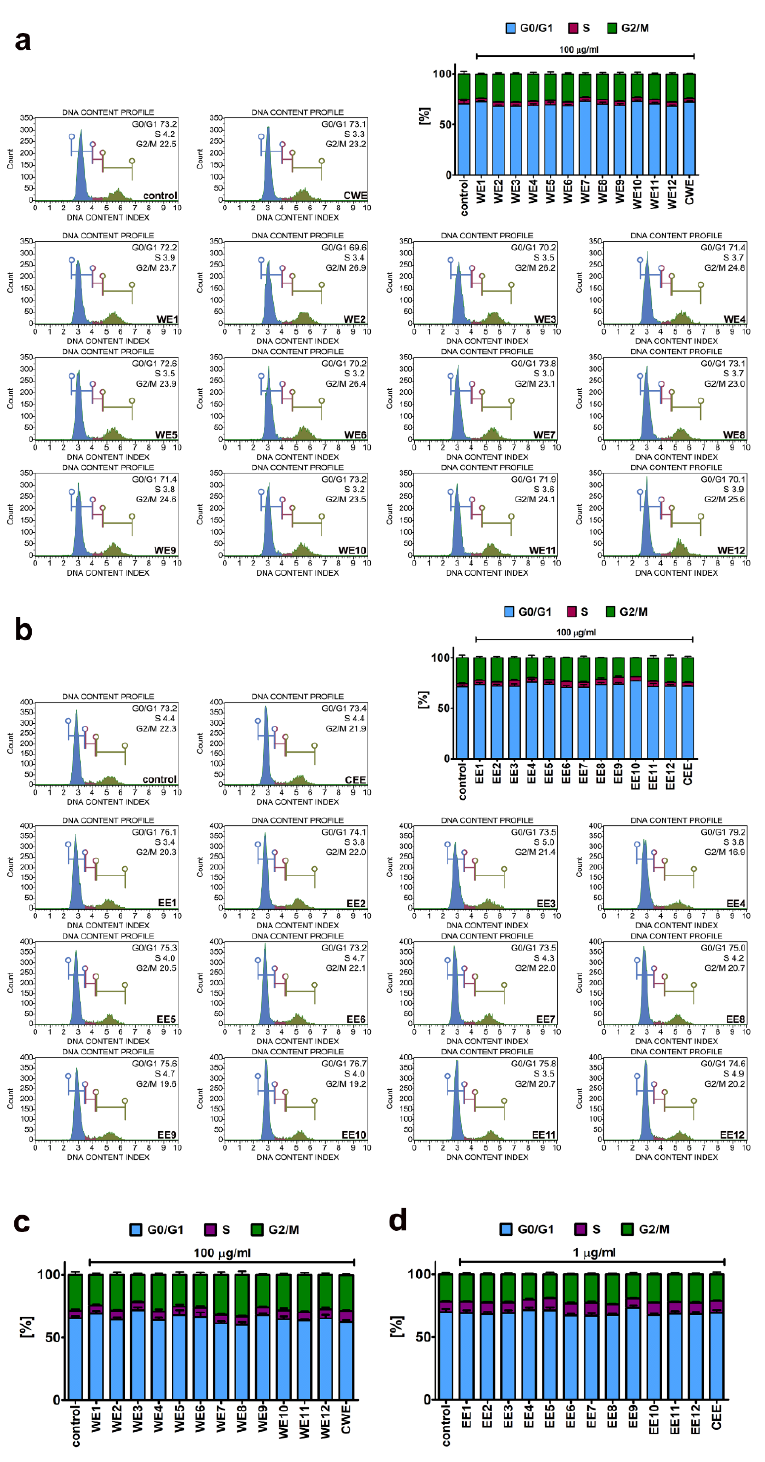
Figure 3. Extract-mediated changes in the cell cycle of BJ cells (( a ), 100 µ g / mL water extracts; ( b ), 100 µ g / mL ethanolic extracts) and HEK cells (( c ), 100 µ g / mL water extracts; ( d ), 1 µ g / mL ethanolic extracts). ( a , c ) The e ff ects of water extracts (WE, twelve modified clones from WE1 to WE12) are shown. Control clone water extract is denoted as CWE. ( b , d ) The e ff ects of ethanolic extracts (EE, twelve modified clones from EE1 to EE12) are shown. Control clone ethanolic extract is denoted as CEE. The percentage of cells in the G0 / G1, S, and G2 / M phases of the cell cycle was assessed using a Muse ® Cell Analyzer and a Muse ® Cell Cycle Kit. Representative histograms are shown (BJ cells). Bars indicate SD, n = 3.